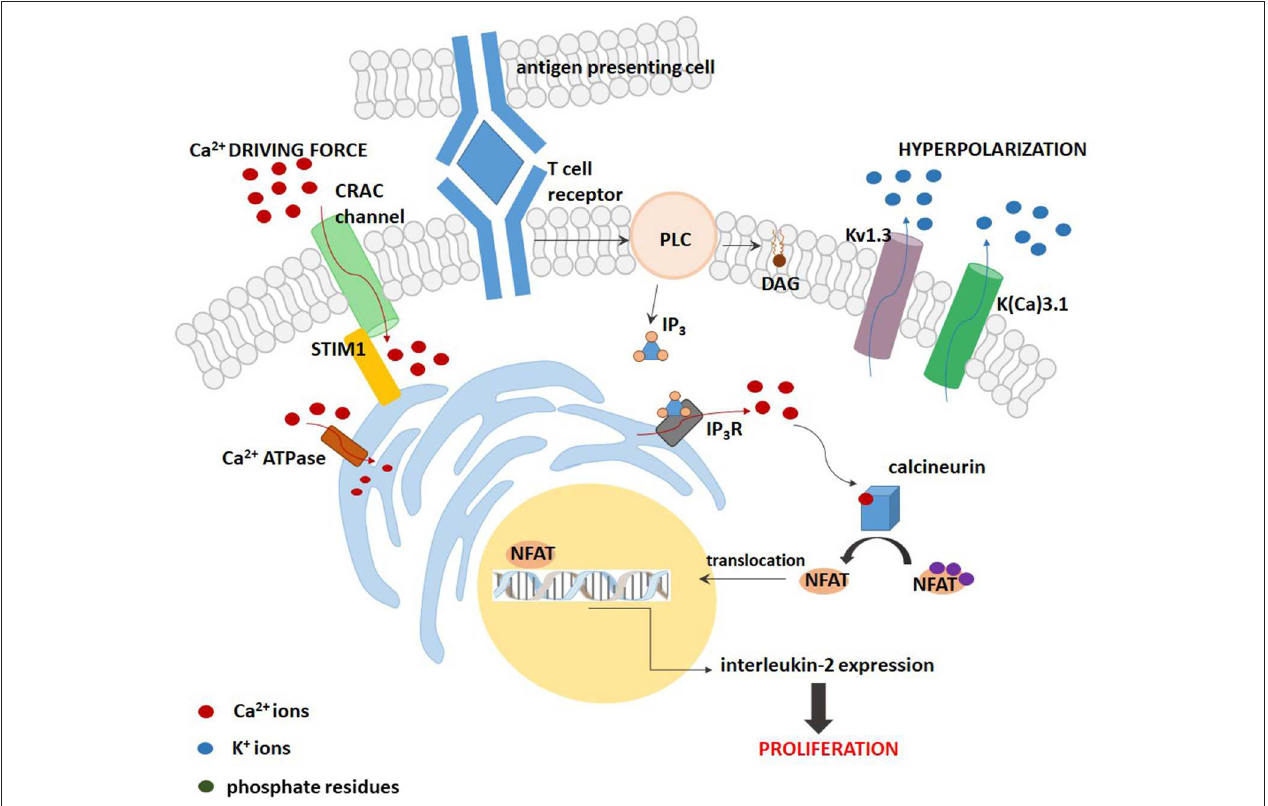
FIGURE 1 | A scheme of the “membrane potential model” for the contribution of Kv1.3 and K(Ca) channels to proliferation of T